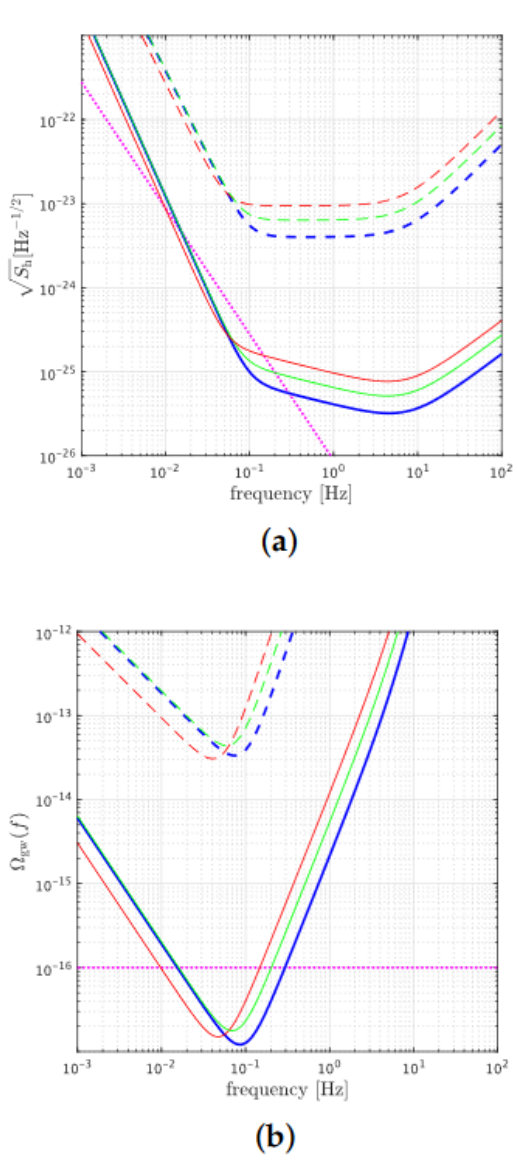
Figure 8. Sensitivity curves for one cluster (dashed lines) and the correlation of two clusters in DECIGO (solid lines) in terms of strain sensitivity ( a ) and normalized energy density ( b ). The blue line shows the case for the optimized parameters in Table 2, the green line shows the case for the default design without the effect of the diffraction loss, and the red line shows the case for the default design with the effect of the diffraction loss. The dotted magenta line shows the primordial GWs in Equation (1) with Ω gw = 1 × 10 − 16